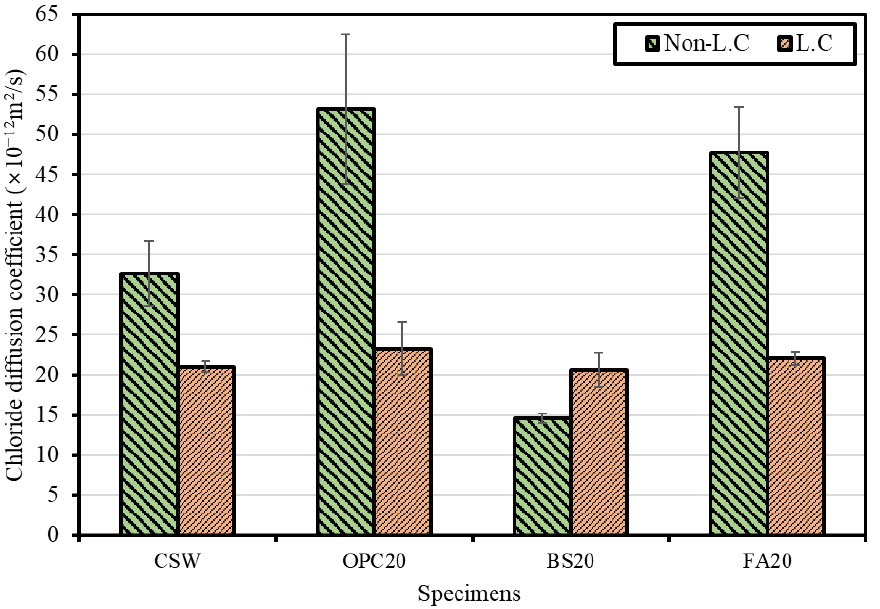
Figure 17. Chloride diffusion coefficient measurements.